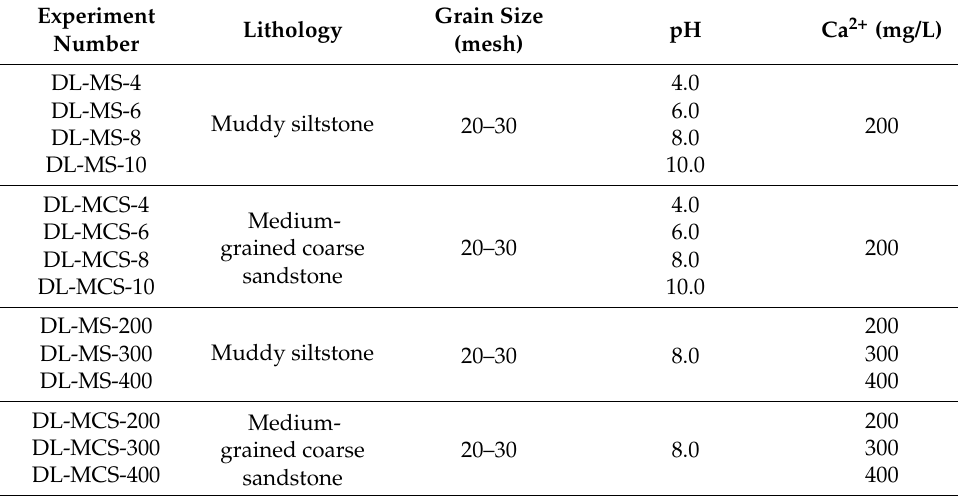
Table 2. Dynamic leaching test scheme.